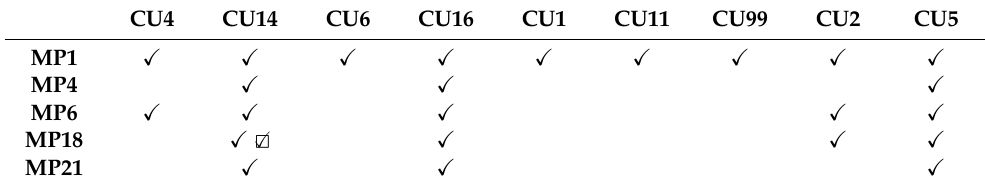
Table 3. The MP and CU (Table 1) combinations used in the 15 km × 15 km resolution ensemble experiments. Check symbols ( (cid:88) ) indicate combinations using the “standard” model parameters L e = 106 km, T con = 28 ◦ C, δ T = 1 ◦ C, and U h = 5 m/s and all three Z 26 values (Table 2) (144 members), and check-and-square symbol ( ) indicates the combination using “non-standard” parameters (cid:50)(cid:8) L e = 212 km, T con = 27 and 29 ◦ C, δ T = 2 ◦ C, and U h = 1 m/s, each run with other parameters fixed at the “standard” values (8 members); see